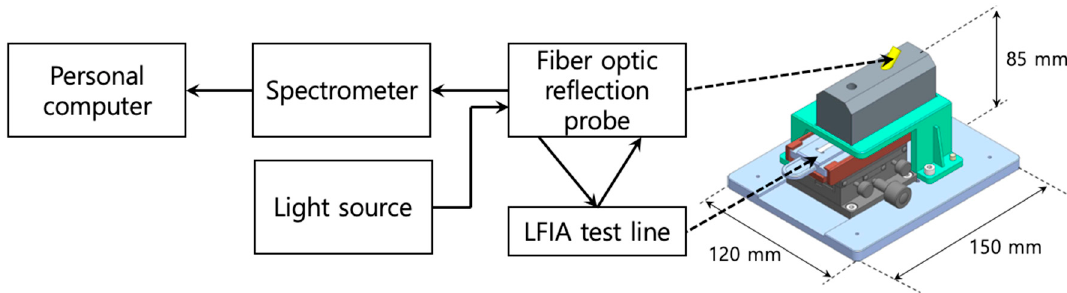
Figure 1. Setup for the spectrometry measurement of the lateral flow immunoassay (LFIA) test line. The white light was from a halogen light source, and the reflected light from the test line was measured using a spectrometer.